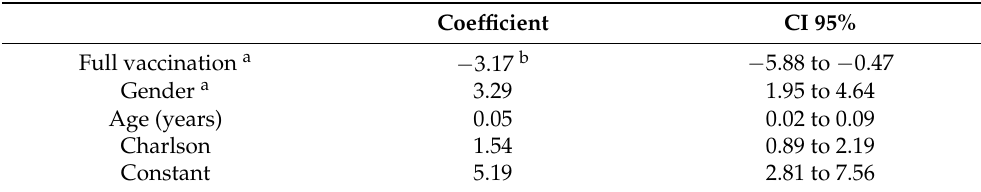
Table 4. Linear regression model of hospital stay in patients discharged on the basis of